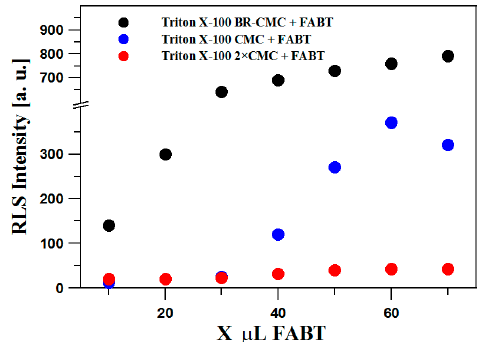
Figure 6. Spectra of resonance light scattering (RLS) in an experiment analogical to that in Figures 2– 7, 9 and 10. The measurements were performed at the temperature of 22 °C.